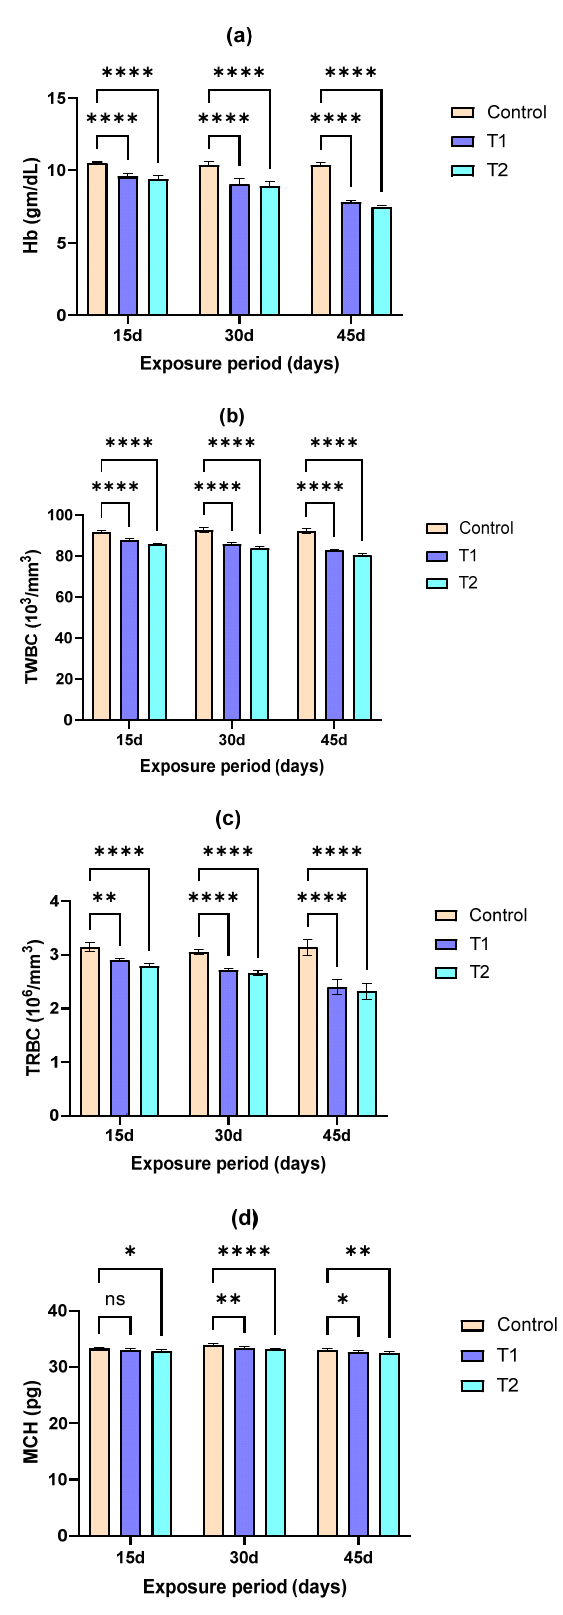
Figure 1. ( a – d ) Mean and SD values of hematological profiles and indices of Clarias batrachus exposed to different concentrations of diazinon (0.64 and 1.28 mg/L) for different exposure times (15, 30, and 45 days). *—denotes significant differences to control within the same exposure time (* p < 0.05, ** p < 0.01, and **** p < 0.0001). ( a ) Hemoglobin; ( b ) total white blood cells; ( c ) total red blood cells; ( d ) mean corpuscular